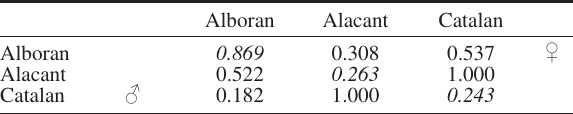
Fig. 6. – Size frequency distributions by sex in Pasiphaea sivado from the Alboran Sea, Alacant area and Catalan Sea geographic sec- tors; males grey bars and females white bars. The sex ratio, as a pro- portion of males, is represented by circles, with indication of values showing a significant (p<0.05, dark circles) or non-significant ( n.s ., light circles) deviation from an expected 1:1 ratio. The total number of individuals analysed by geographic area is presented. Table 2. – Comparison of size frequency distributions between geographic populations (Kolmogorov-Smirnov test). The p values for the comparison between females are presented above the diago- nal, those between males below the diagonal, and those comparing males and females within each population along the main diagonal (values in